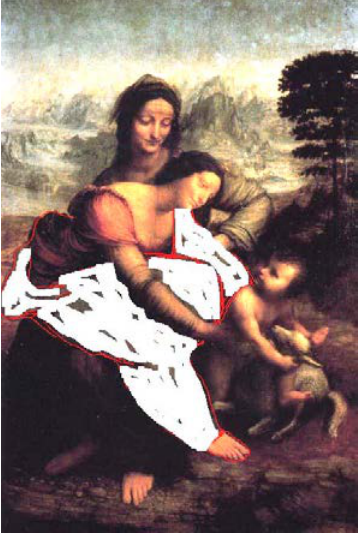
Figure 4 Wall scroll painted by malin,1264;ink on silk,110 Figure 5 Leonardo da venci,The virigin&child with st,Anne oil on wood, cm wide. 168×130cm, Louvre